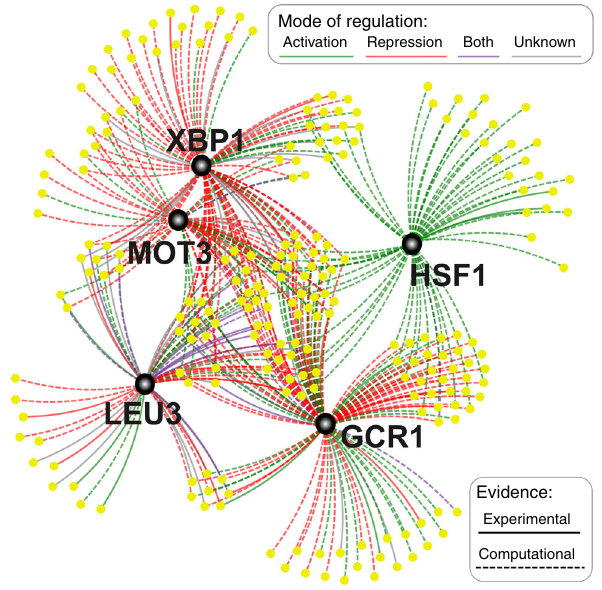
Fig. 9 Transcriptional network of genes involved in gene expression shift towards WT. Black nodes indicate TFs whose motifs were enriched in the promoters of shift-associated genes (yellow